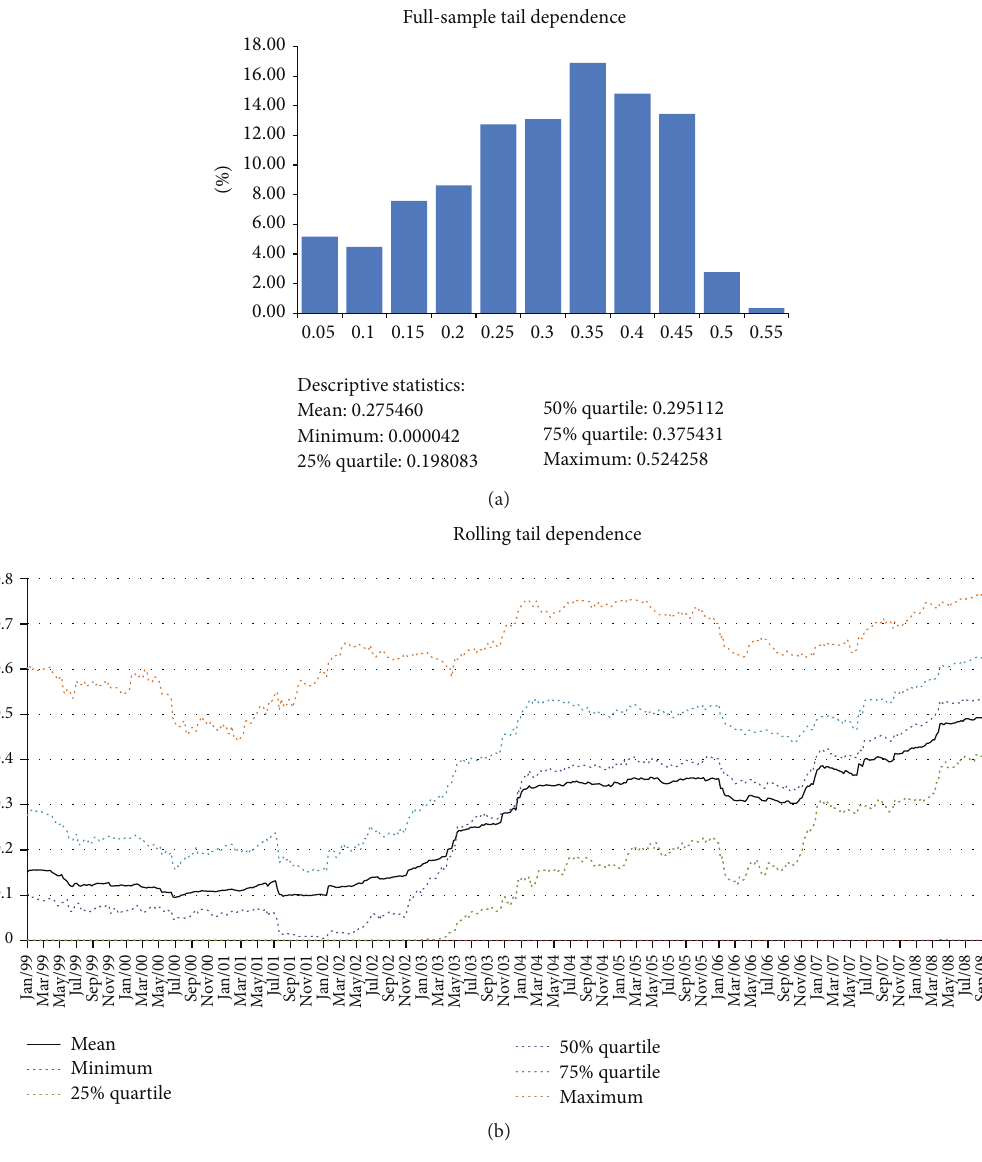
Figure 2: The existence of tail dependence. To verify the existence of tail dependence, we show the distribution of full-sample (1997–2008) tail dependence by the histogram and the related statistics in (a). At each time 𝑡 , we employ previous two years’ observations to estimate the tail dependences for all stocks and provide the dynamics of their mean, minimum, three quartiles, and maximum from 1999 to 2008 in (b).